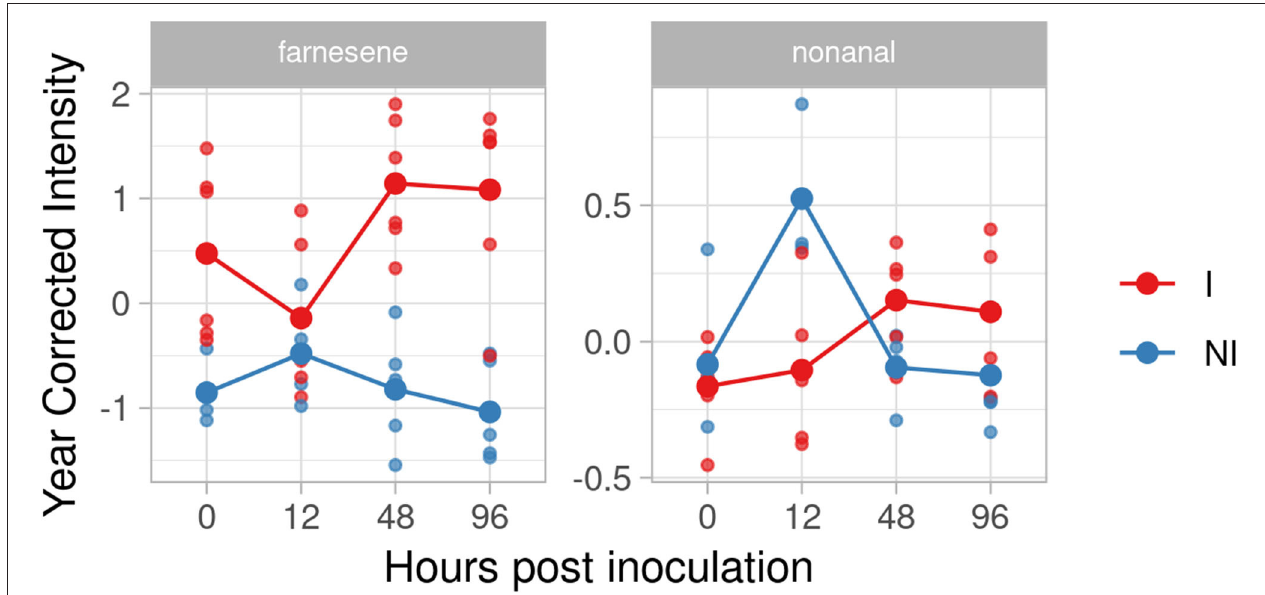
FIGURE 8 | Graphs for specific putative biomarkers of resistance to Plasmopara viticola in inoculated (Red) and not inoculated (Blue) F12P127 genotype. Values of the 2 years are reported subtracting the year’s effect.